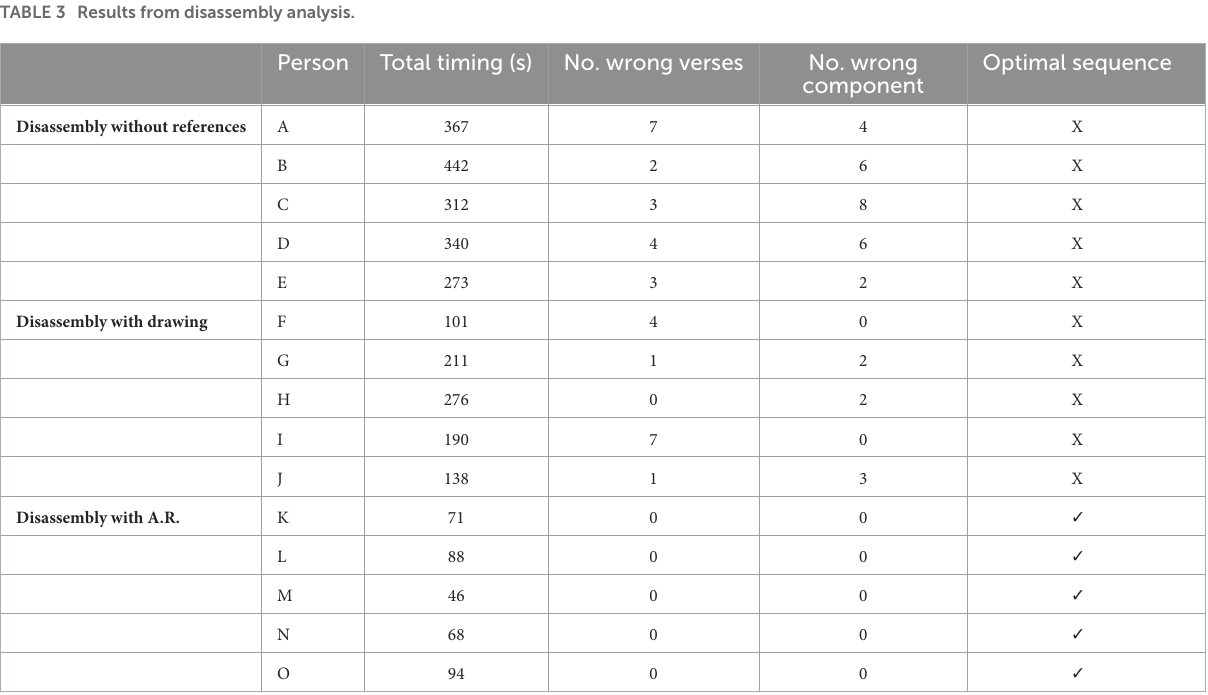
TABLE 3 Results from disassembly